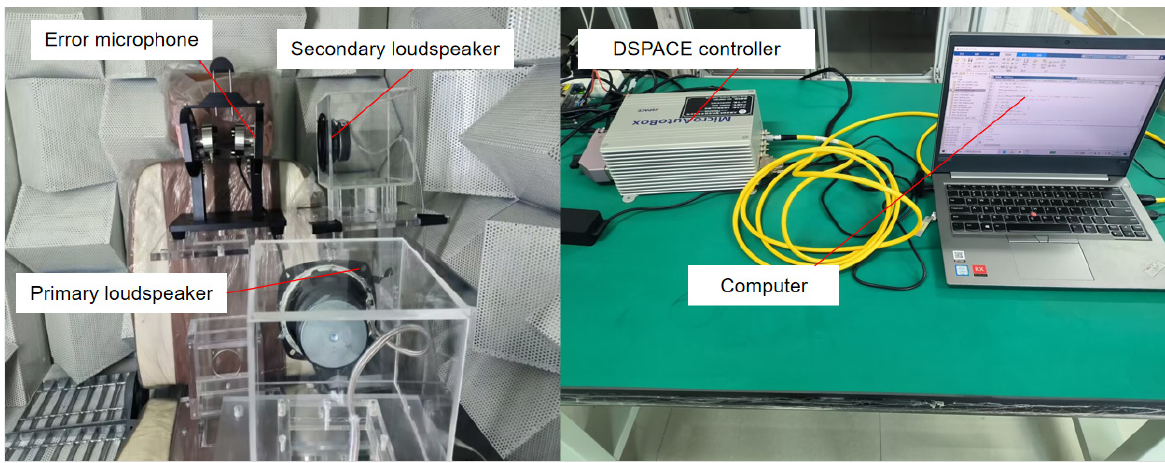
Figure 12. Schematic diagram of the ANC experiment.